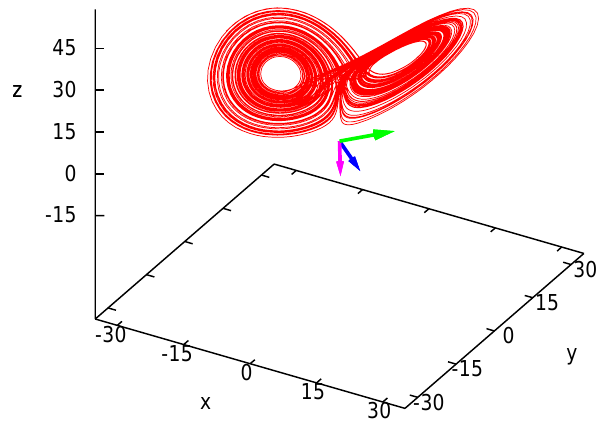
Fig. 1. The Lorenz 63 attractor (red) and its EOFs p 1 (green), p 2 (purple), and p 3